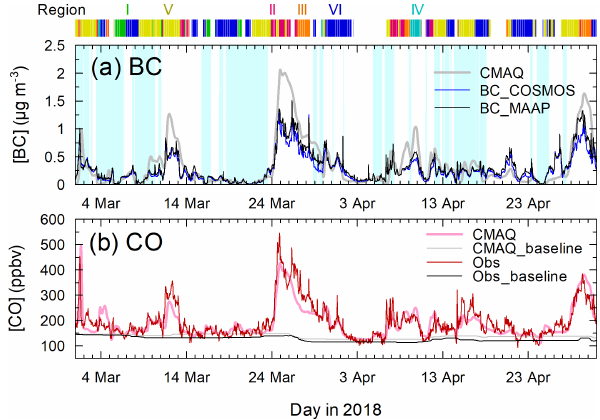
Figure 4. Black carbon (BC) mass concentrations and CO mix- ing ratios from observations and model simulations during the EMeRGe–Asia campaign. The air mass origin areas are indicated with colored vertical bars above panel (a) . The light blue bands in panel (a) indicate the periods with accumulated precipitation along trajectory